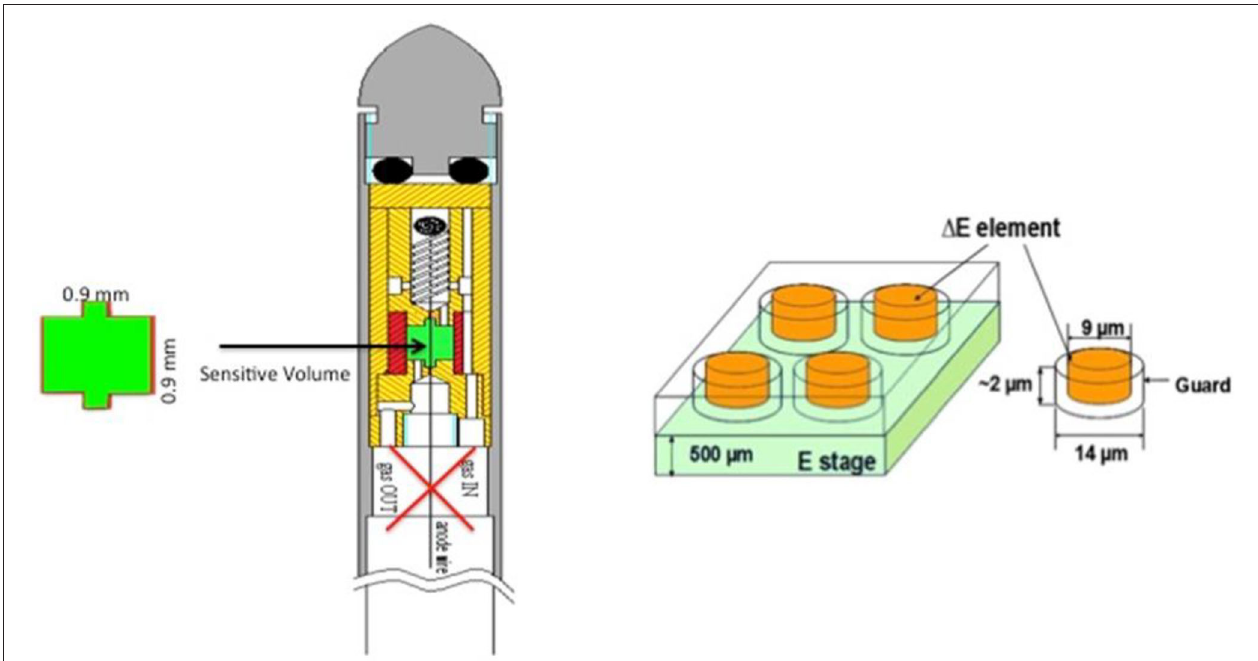
FIGURE 3 | (Left) : Cross section of the mini-tissue-equivalent proportional counter (TEPC); the green area is the detector sensitive volume; the red cross points out the possibility to work both in gas flow modality and in sealed modality [ 14]. (Right) : Sketch of the pixelated silicon telescope with four (out of many) sensitive elements [13].